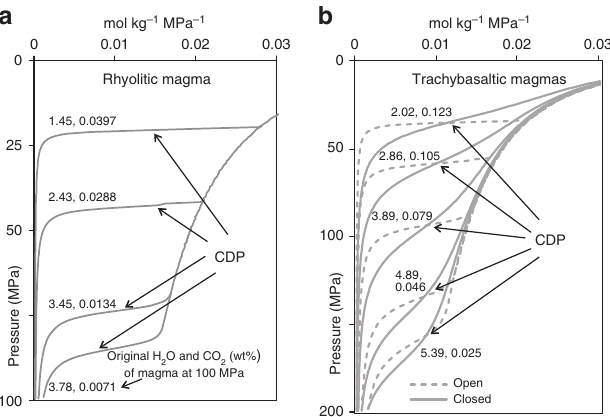
Figure 2 | Results of magma degassing models. The different curves refer to different initial H 2 O and CO 2 contents, reported as couple of values on each and describe the evolution of the fluids released during magma depressurization in various conditions. ( a ) Theoretical degassing curves were calculated for rhyolitic magma compositions and show the pressure dependence of the moles of H 2 O and CO 2 released during open-system degassing by one kilogram of magma for each 1-MPa pressure decrease. ( b ) Theoretical degassing curves were calculated for the most-primitive magma compositions of CFc and refer to open and closed degassing (trachybasalt).